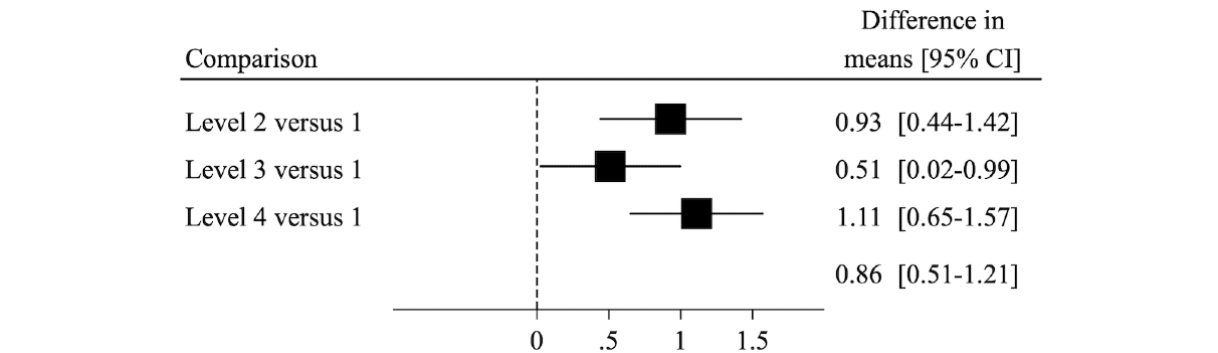
Figure 2. Difference in mean change in an overall lifestyle score (range 0-20) from baseline to 3 months, comparing intervention levels 2 to 4 with level 1. Higher scores indicate more healthy lifestyle behaviors. These secondary analyses included the 146 men with complete data on lifestyle behaviors at 0 and 3